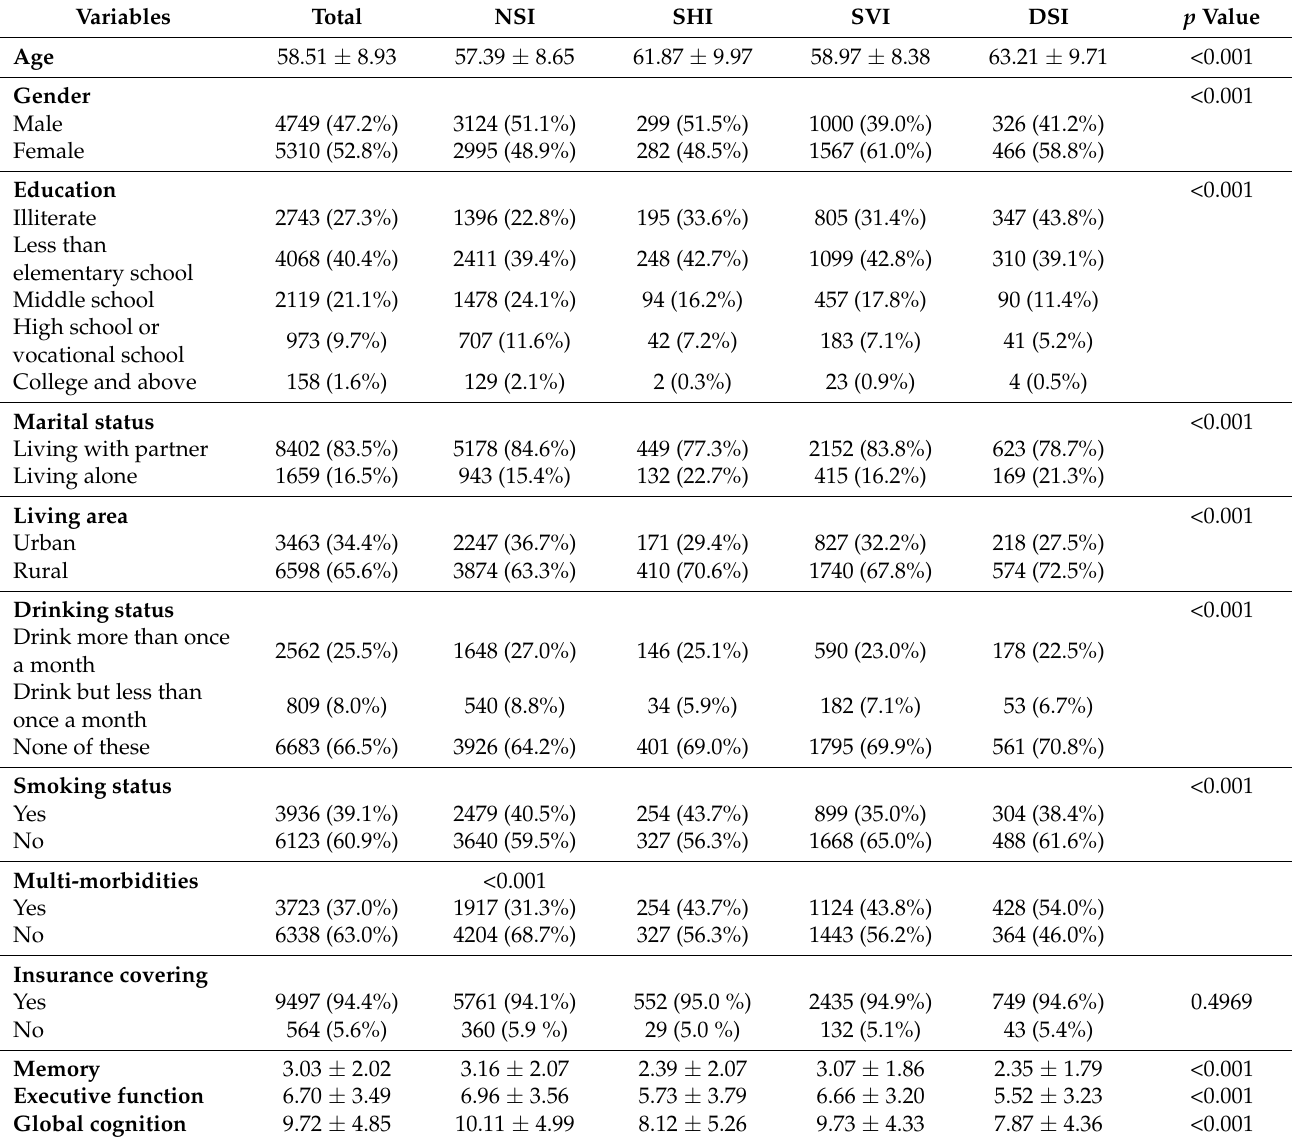
Table 1. Baseline characteristics of study sample from CHARLS